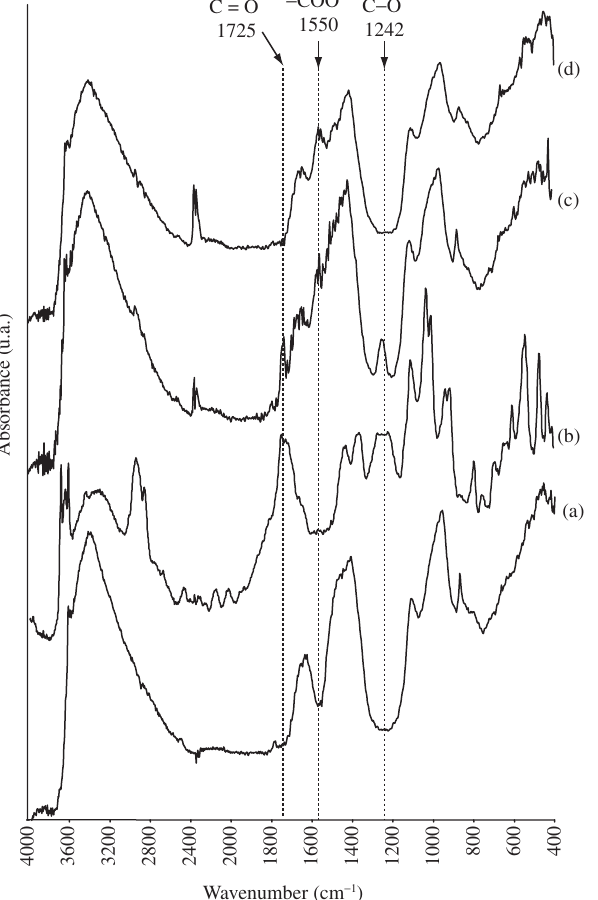
Figure 11. a) FTIR spectrum cement paste used as reference (without EVA), b) EVA copolymer, c) Cement paste modified with 10% of EVA aged for 28 days and d) 150 days.